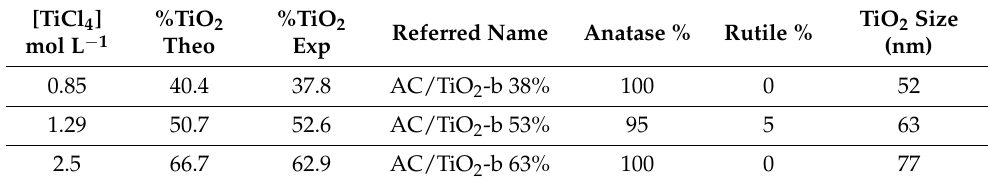
Table 1. The theoretical and experimental mass composition (%TiO 2 theo and %TiO 2 exp), referred name, percentage of anatase and rutile structure percentage (anatase %, rutile %), and crystallite average size (TiO 2 size) as a function of TiCl 4 concentration.